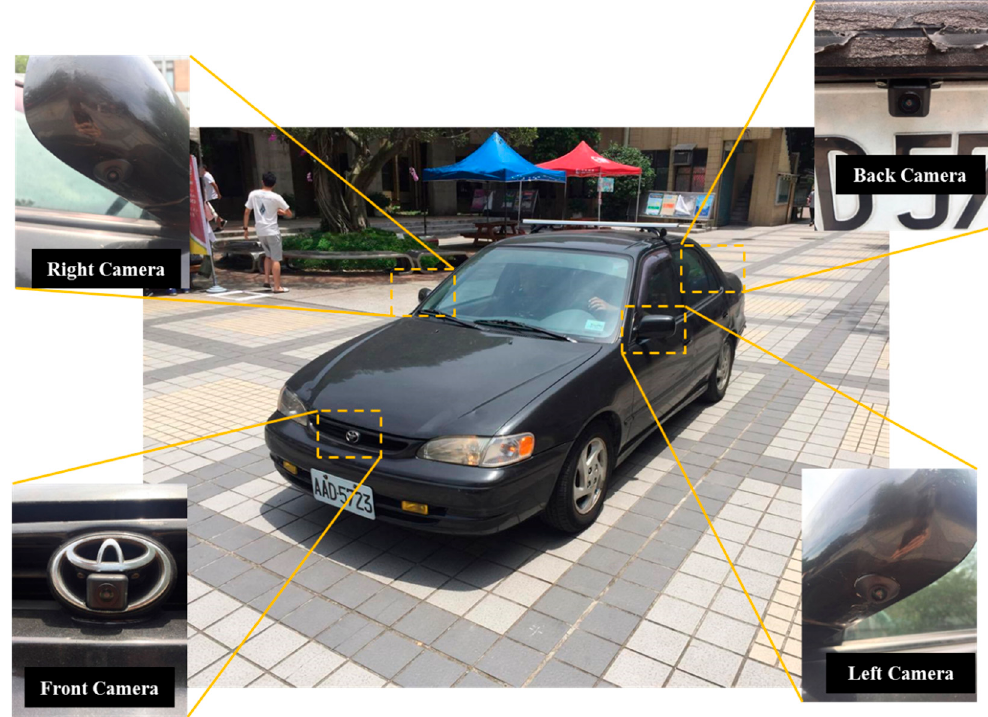
Figure 20. Around view monitoring (AVM) lens locations.